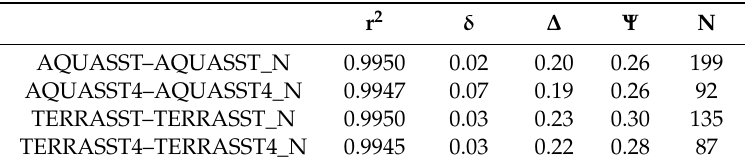
Table 3. Comparison statistics between the RS SST values from the cell containing the in situ data loggers and its northern adjacent cell, both for the MODIS AQUA and the MODIS TERRA datasets. The squared Pearson correlation coe ffi cient (r 2 ), the mean bias ( δ ), the mean absolute error ( ∆ ), the root mean squared error ( Ψ ), and the number of matchups taken into account are